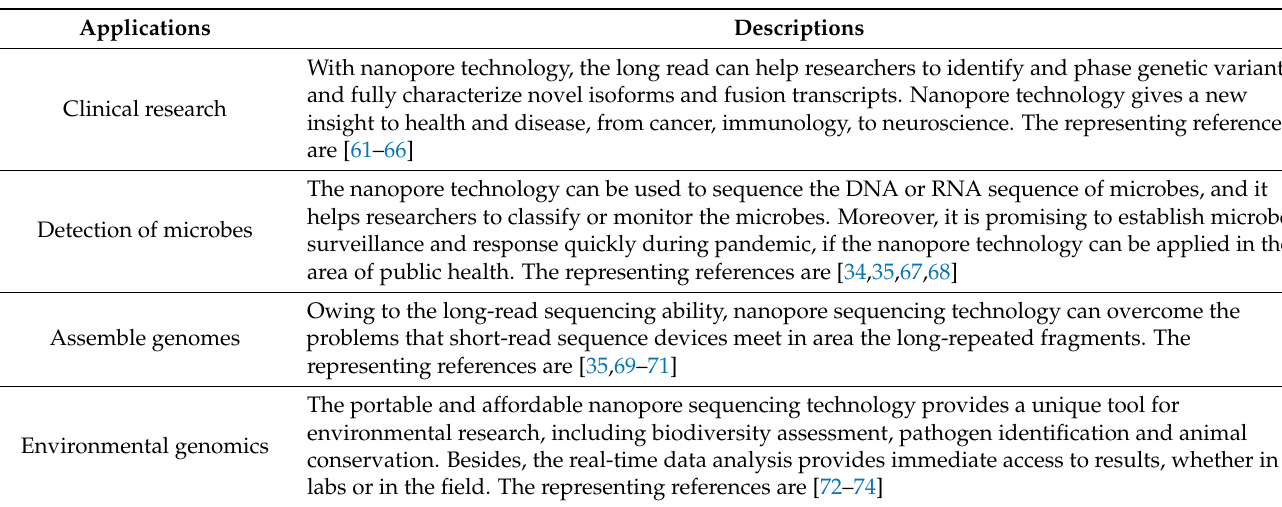
Table 3. Applications of Nanopore